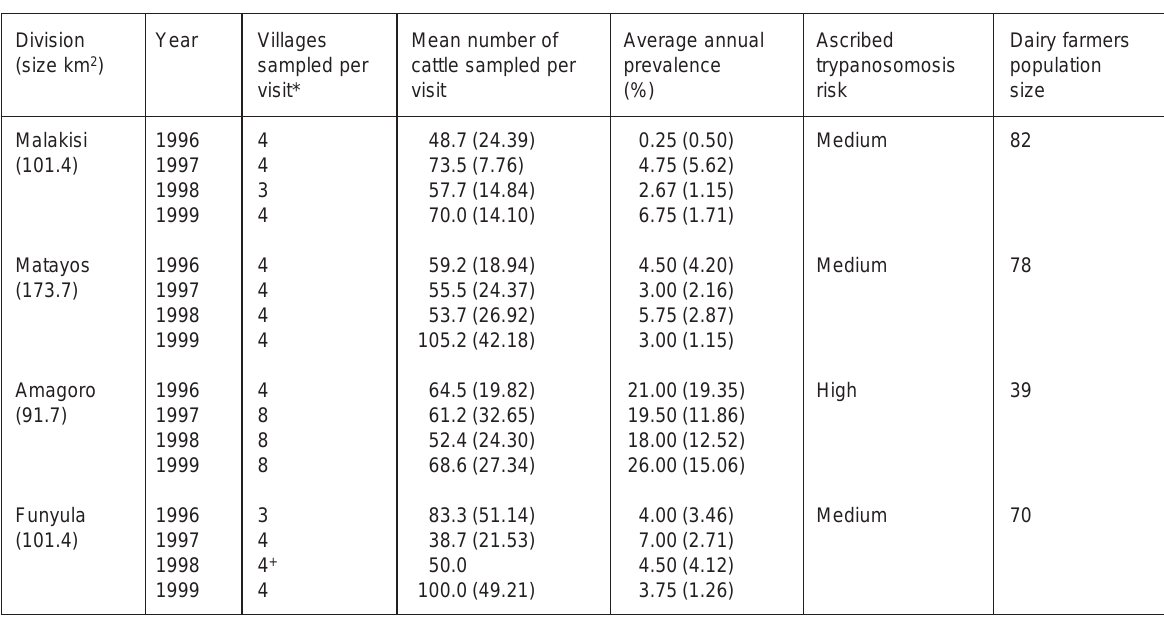
TABLE 1 Summary information on study